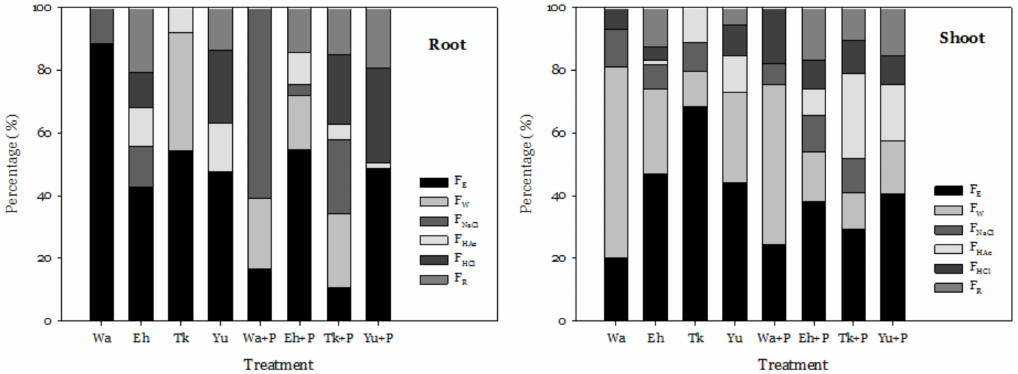
Figure 4. E ff ect of adding P on the chemical forms of Cd in the roots and shoots of water spinach. The meanings of the abbreviations are the same as in Table